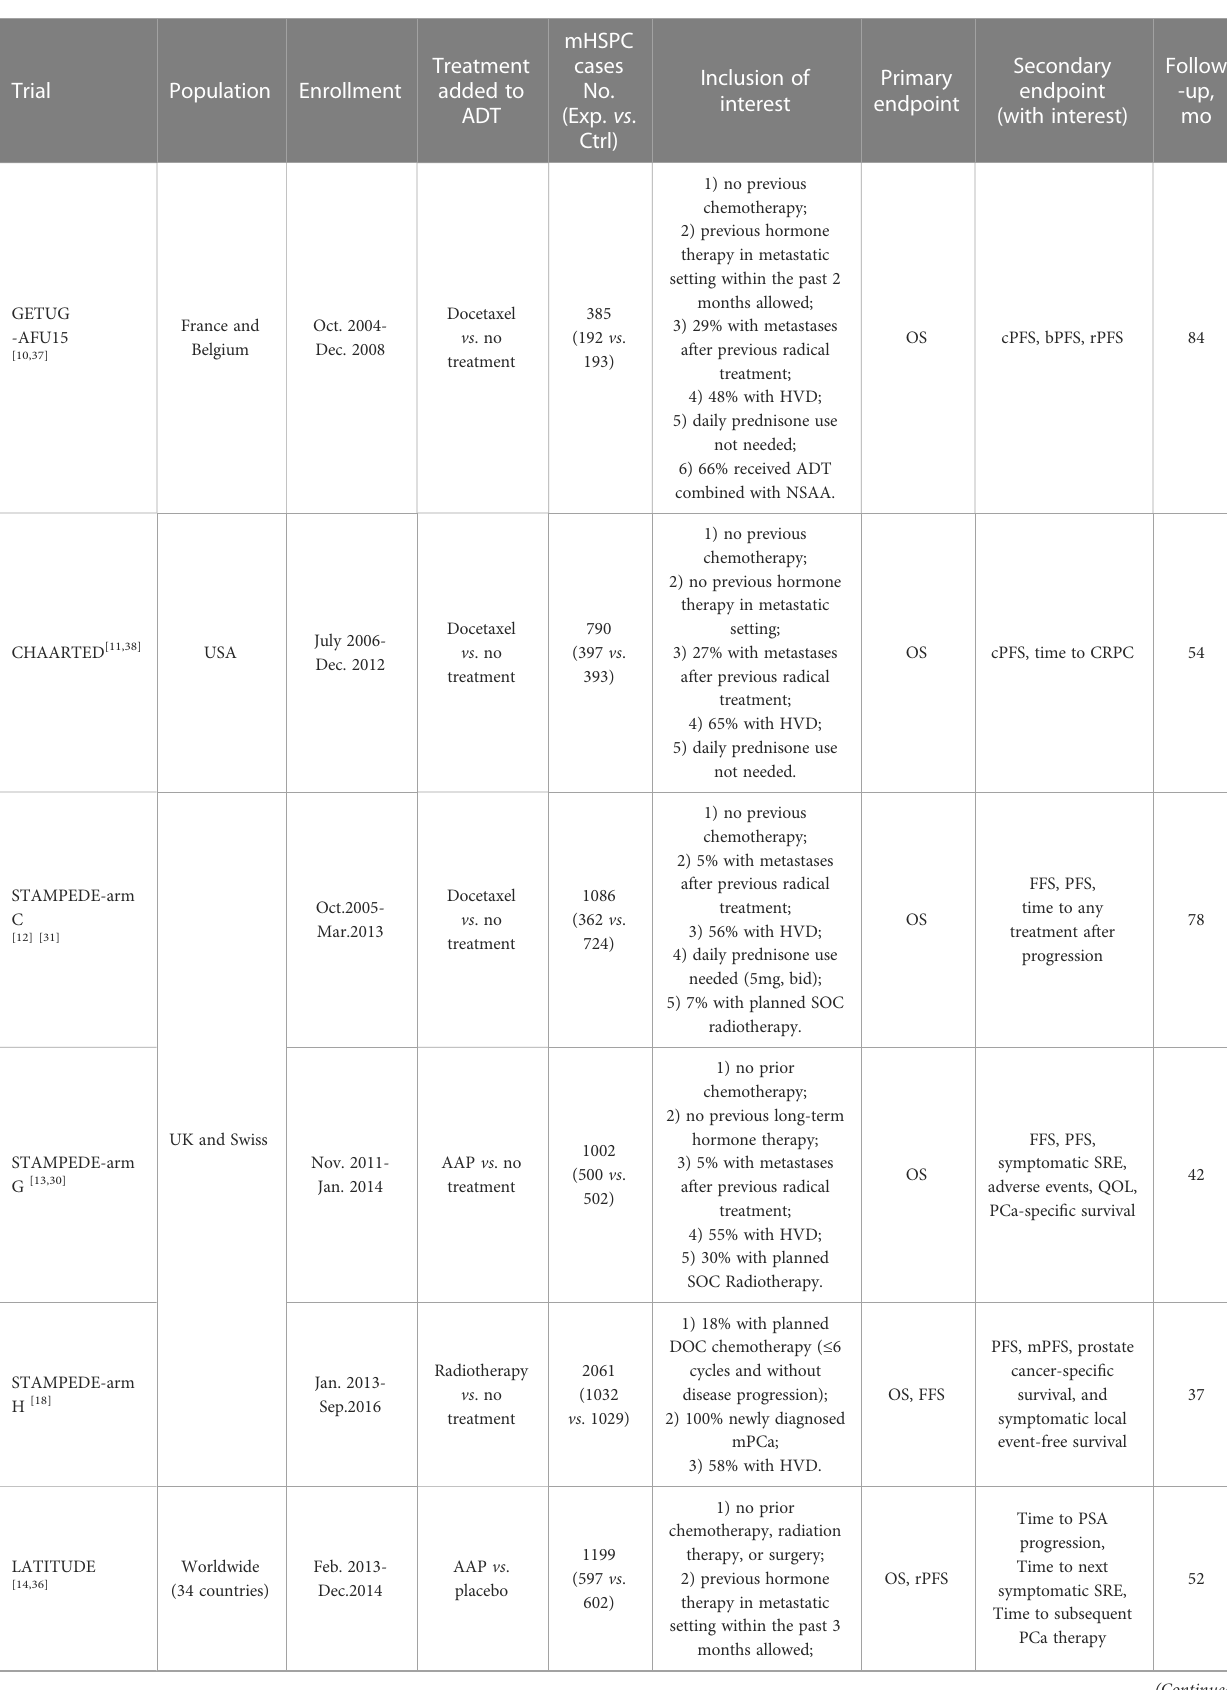
TABLE 1 Characteristics of included